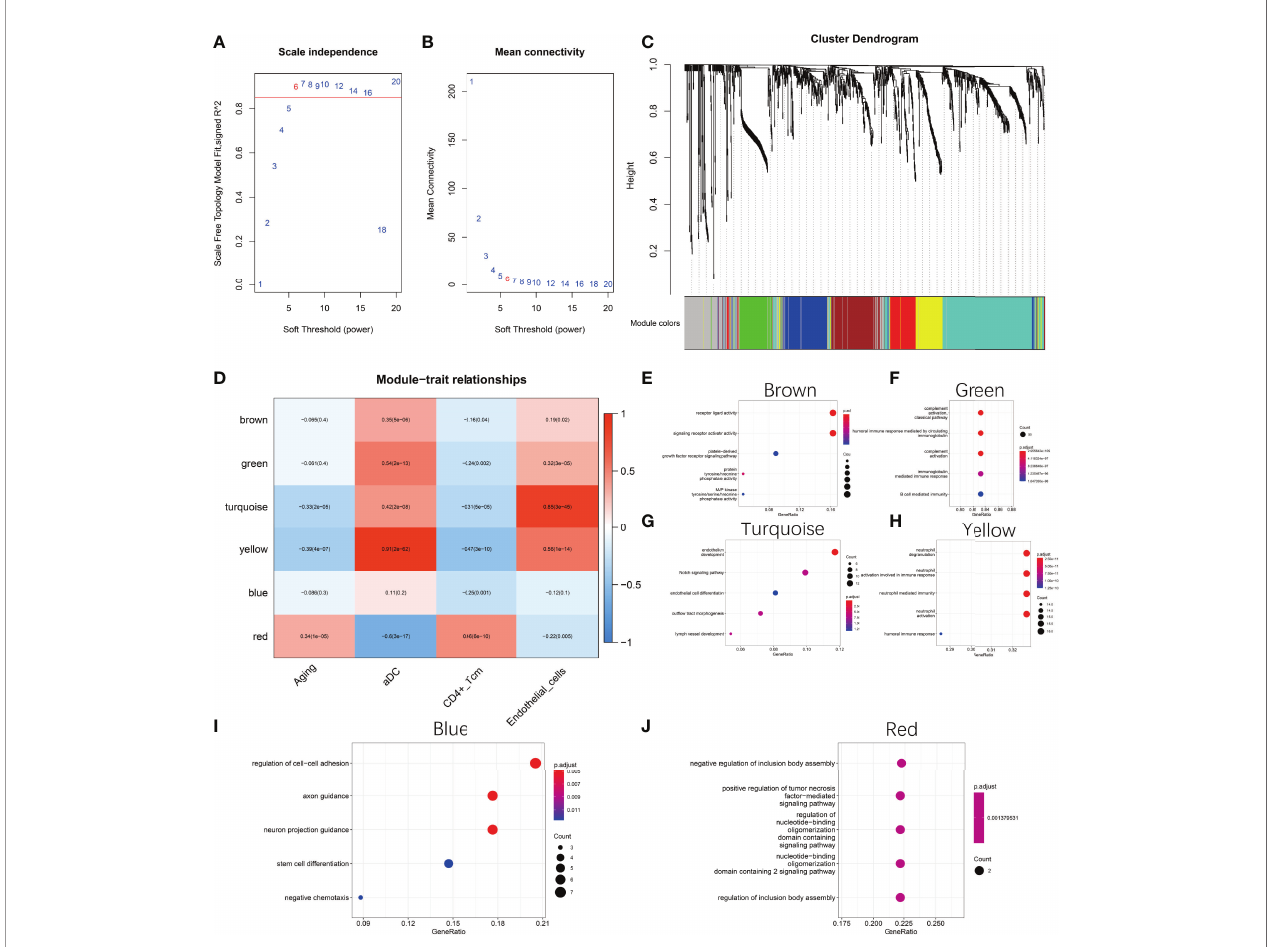
FIGURE 3 | Weighted gene co-expression network analysis (WGCNA). (A, B) Selection of the best soft threshold. (C) Six co-expression modules were obtained for genes with fusion distance less than 0.25. Among them, the grey modules contained genes that could not be clustered. (D) Correlation of modules with phenotypes. (E) Functional enrichment analysis of Brown module hub genes (F) Functional enrichment analysis of Green module hub genes (G) Functional enrichment analysis of Turquoise module hub genes (H) Functional enrichment analysis of Yellow module hub genes (I) Functional enrichment analysis of Blue module hub genes (J) Functional enrichment analysis of Red Module hub genes functional enrichment analysis. The hub genes of each module are selected based on MM values greater than